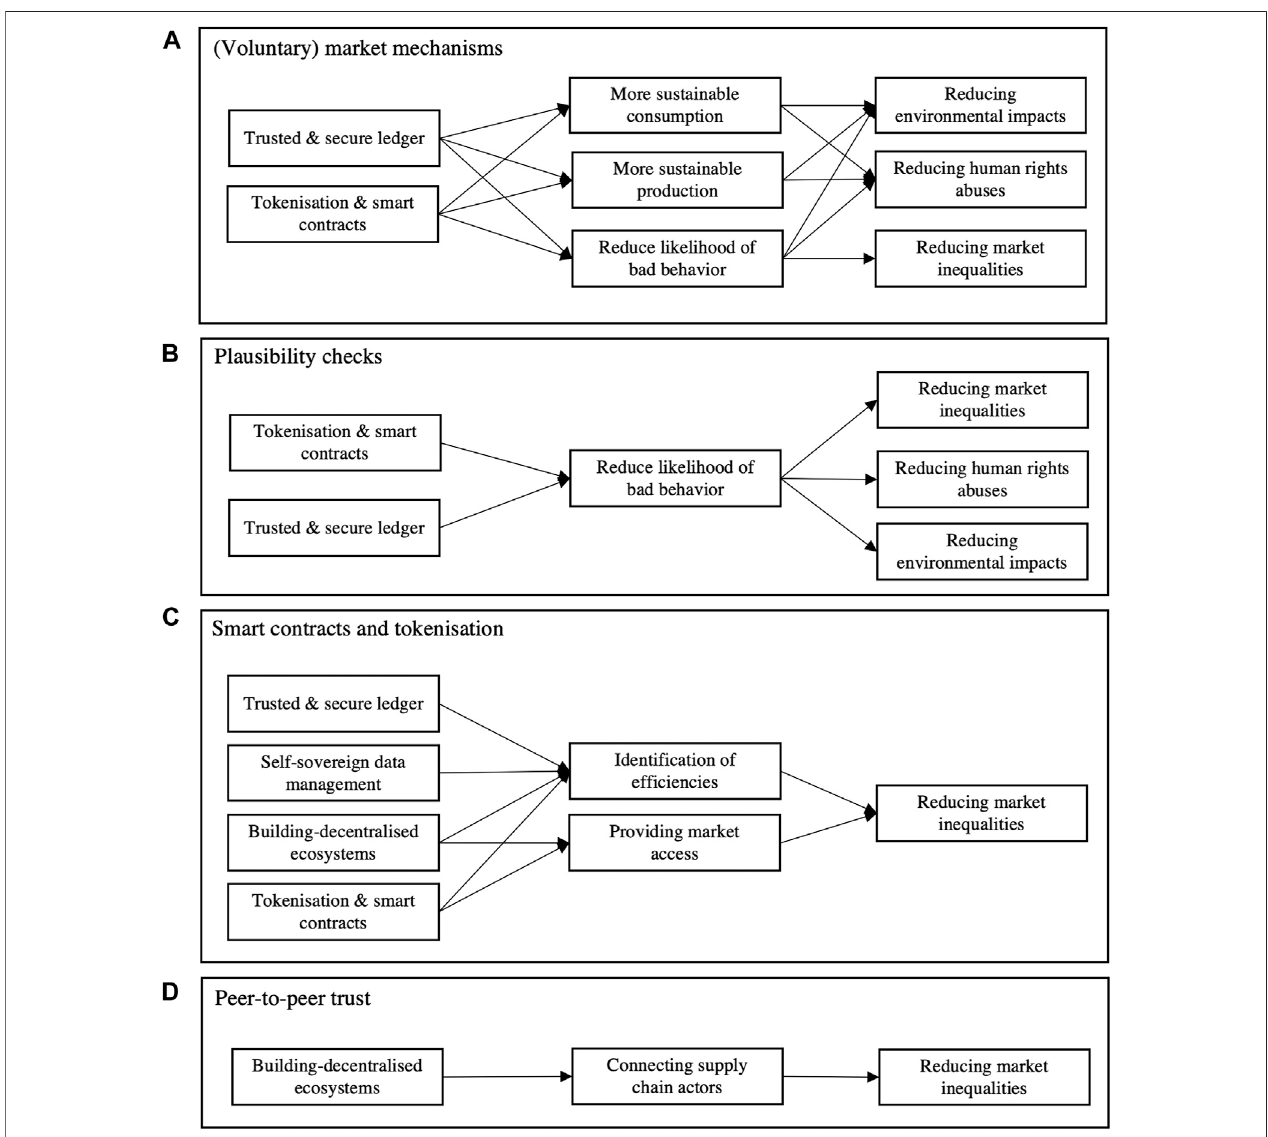
FIGURE 3 | Impact Pathways and Mechanisms. Four mechanisms creating positive environmental and social impact have been identi fi ed. They are depicted in boxes (A – D) . Within each box it is shown how the outputs ( fi rst column) in fl uence the outcomes (middle column) and how the outcomes in fl uence the resulting impacts (last column). The arrows link these boxes portraying impact